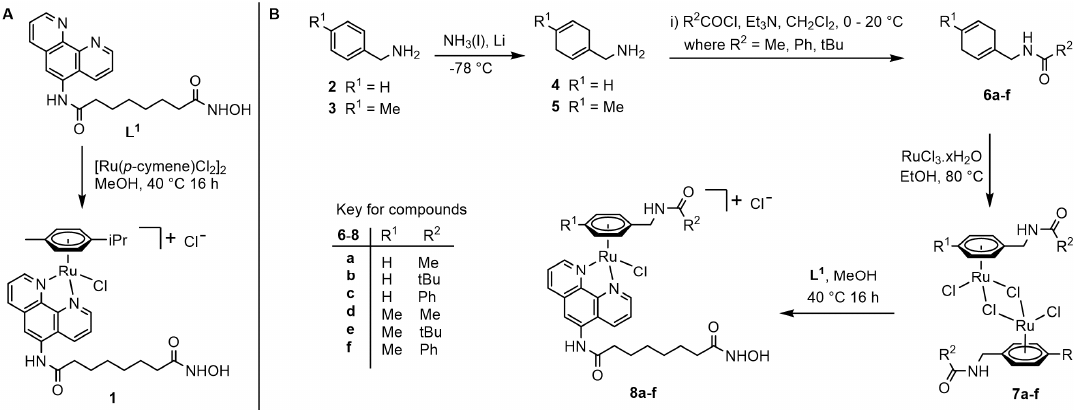
Figure 2. HDAC1 and HDAC6 inhibition assays of Ru complexes 1 and 8a – f , and control compounds,